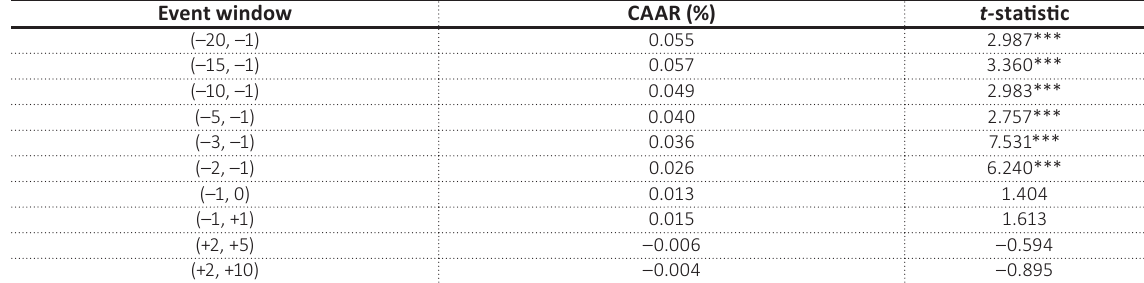
Table 4. CAAR for buyback announcements Event window CAAR (%) t- statistic